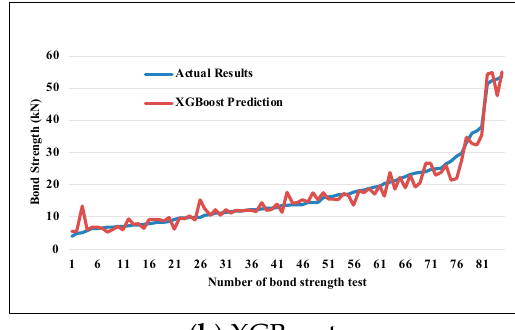
Figure 4. Performance of the ensemble methods: ( a ) explained variance score (EVS), ( b ) mean square error (MSE), ( c ) mean absolute error (MAE), and ( d ) residual error (RE). Figure 5 depicts the performances of the ensemble methods by plotting the predicted bond strength values with a sequence of bond strength tests. The actual and predicted bond strength results of CatBoost more accurately overlapped each other compared to those of the other ensemble methods.